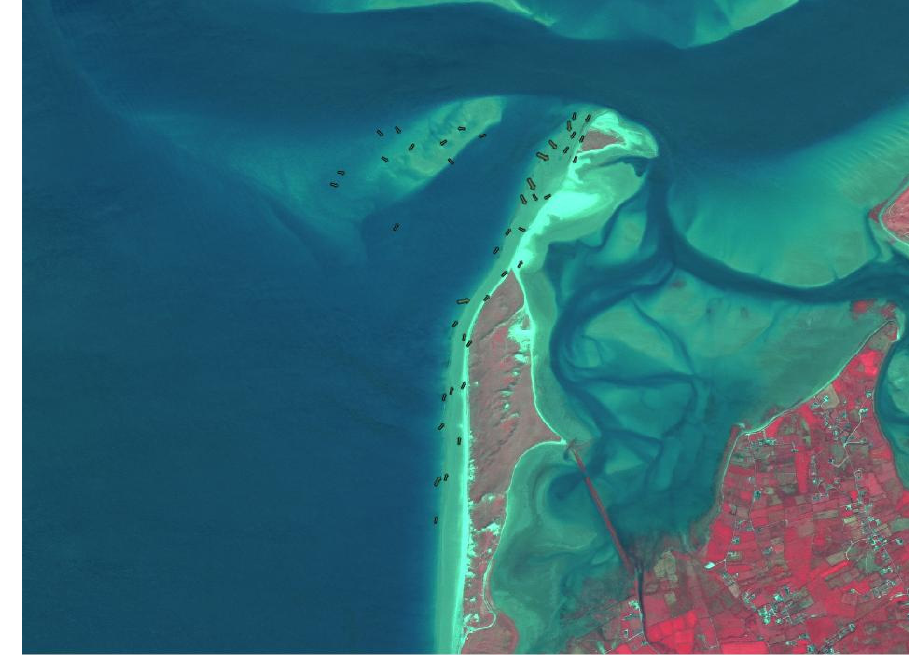
Figure 10. CB+ trend.